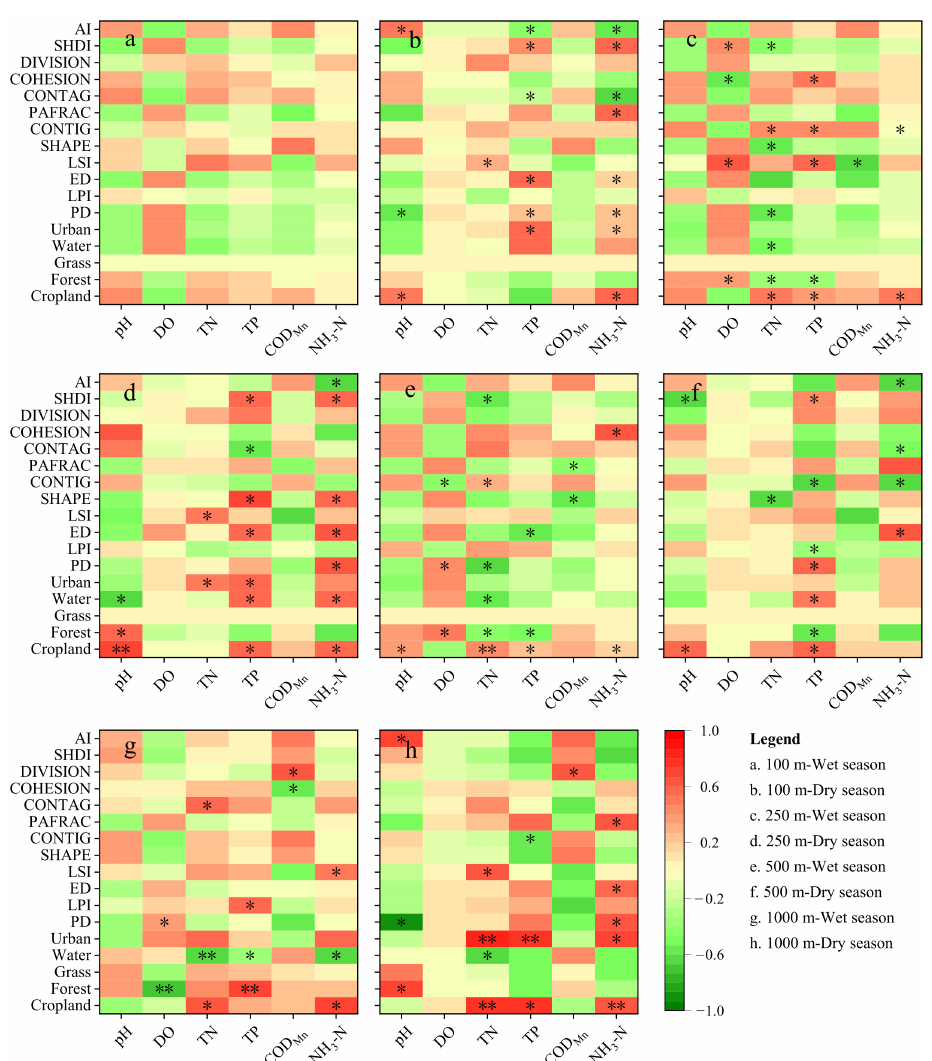
Figure 7. Relationship between land use, landscape pattern, and basin water quality during the dry and wet seasons, at different range scales. Scenarios include 100 m-wet season ( a ) and dry season ( b ), 250 m-wet season ( c ) and dry season ( d ), 500 m-wet season ( e ) and dry season ( f ), 1000 m-wet season ( g ) and dry season ( h ). PD, LPI, ED, LSI, SHAPE, CONTIG, PAFRAC, CONTAG, COHESION, DIVISION, SHDI, and AI mean patch density, largest patch index, edge density, landscape shape index, shape index, contiguity index, perimeter-area fractal dimension, contagion, patch cohesion index, landscape division index, Shannon’s diversity index, and aggregation index, respectively. In this figure, a darker red indicates a higher degree of positive correlation, and a darker green indicates a higher degree of negative correlation. * and ** mean that the correlation was significant at p < 0.05 and p < 0.01,